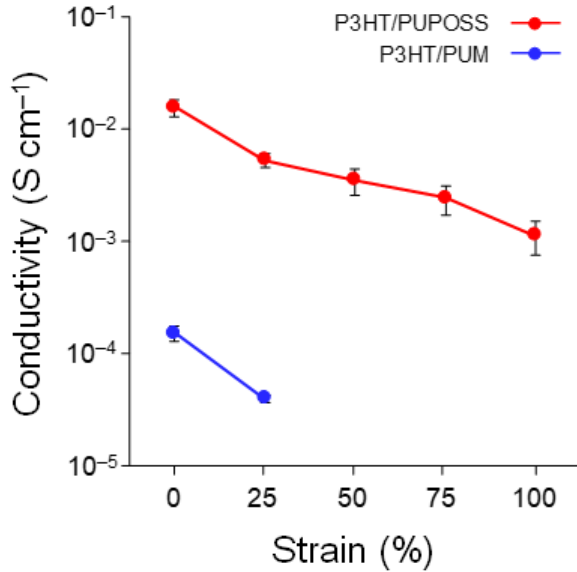
Figure 6. In-plane conductivities of the hybrid films with 20 wt % of doped P3HT under strain.